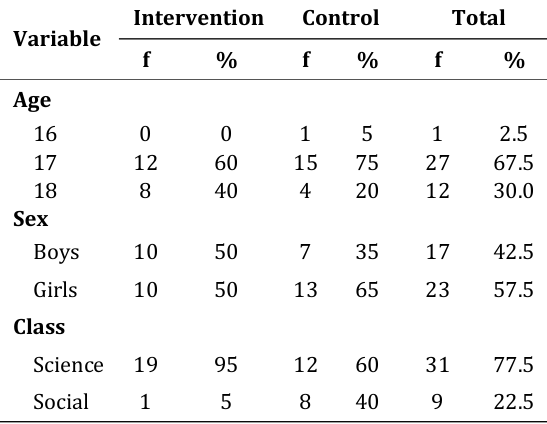
Table 1. Characteristics of respondents